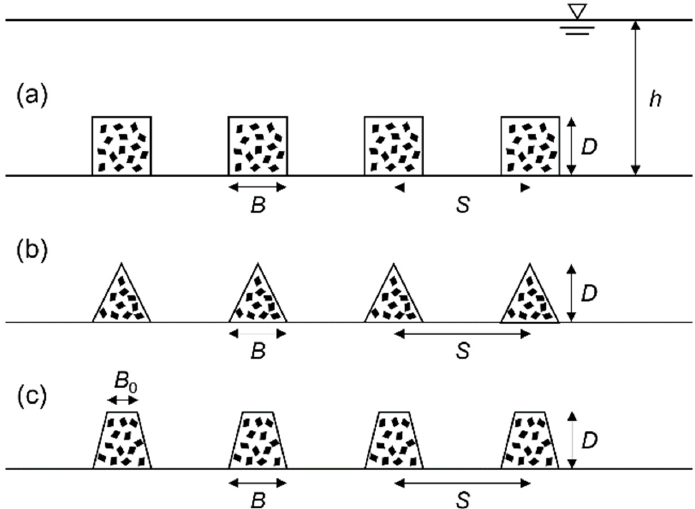
Figure 7. Sketch of porous submerged breakwaters with different section shapes and equal spacing (( a ) rectangle; ( b ) triangle; ( c ) trapezoid. h is the water depth, B is the bar width, B 0 is the short bottom edge of the trapezoidal bars, D is the bar height, and S is the spacing of the two adjacent bars).